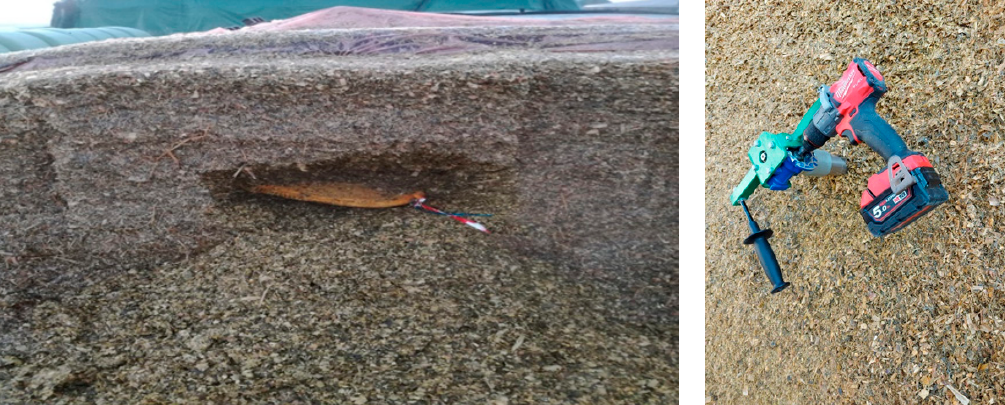
Figure 1. A net-bag buried in a bunker silo ( left ); the electrical probe ( right ) to collect a determined volume of whole-plant maize (WPM) silage used to calculate dry matter density and porosity.